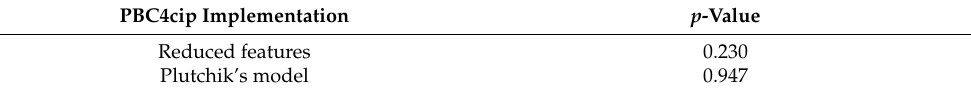
Table 10. p -values for paired t -test among algorithm of PBC4cip